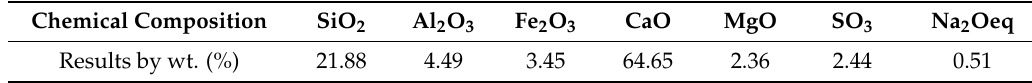
Table 1. Chemical compositions of cement.